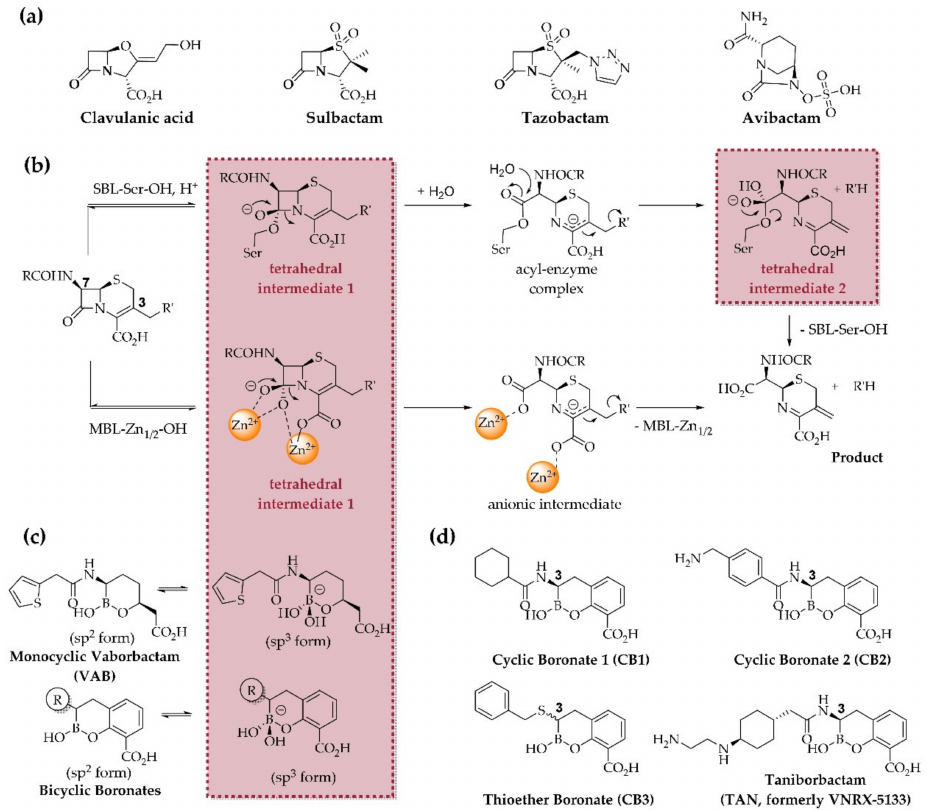
Figure 1. Mechanistic basis for β -lactamase inhibition by (bi)cyclic boronates. ( a ) clinically used β -lactamase inhibitors; ( b ) outline general mechanisms of SBLs and MBLs, exemplified by hydrolysis of a cephalosporin with elimination at C-3’. The tetrahedral intermediates, common to both SBL and MBL catalysis, may be mimicked by the sp 3 form of (bi)cyclic boronates; ( c ) equilibria between sp 2 - and sp 3 -hybridized forms of mono- and bi-cyclic boronates; ( d ) structures of bicyclic boronate β -lactamase inhibitors cyclic boronate 1 (CB1), cyclic boronate 2 (CB2), the thioether boronate (CB3), and taniborbactam (TAN, formerly VNRX-5133). Note that the CB3 used in this study contained a mixture of the (3 S )- and (3 R )-enantiomers (~1:3, respectively)